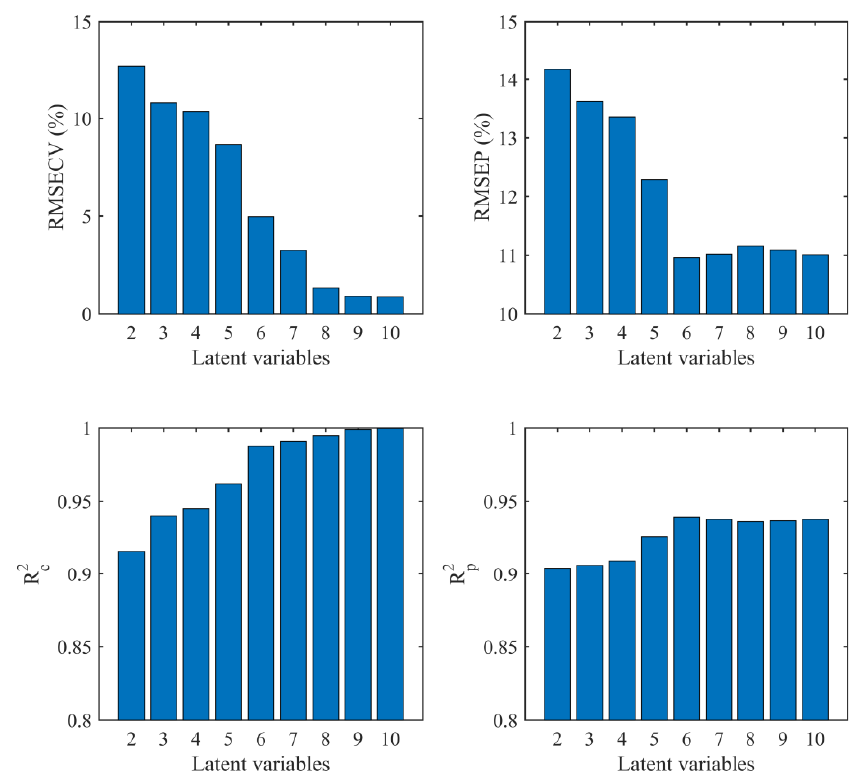
Figure 5. Parameters of RMSECV, RMSEP, R c2 , and R p2 as a function of the first 10 latent variables.